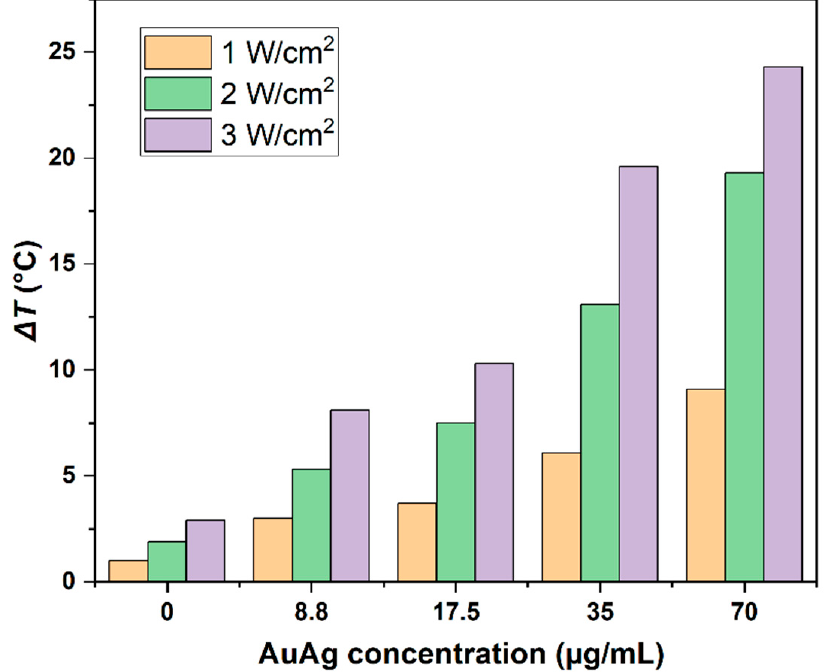
Figure 3. ∆ T induced after irradiation for 5 min at different laser intensity ( P = 1, 2, and 3 W/cm 2 ) and AuAgNTrs